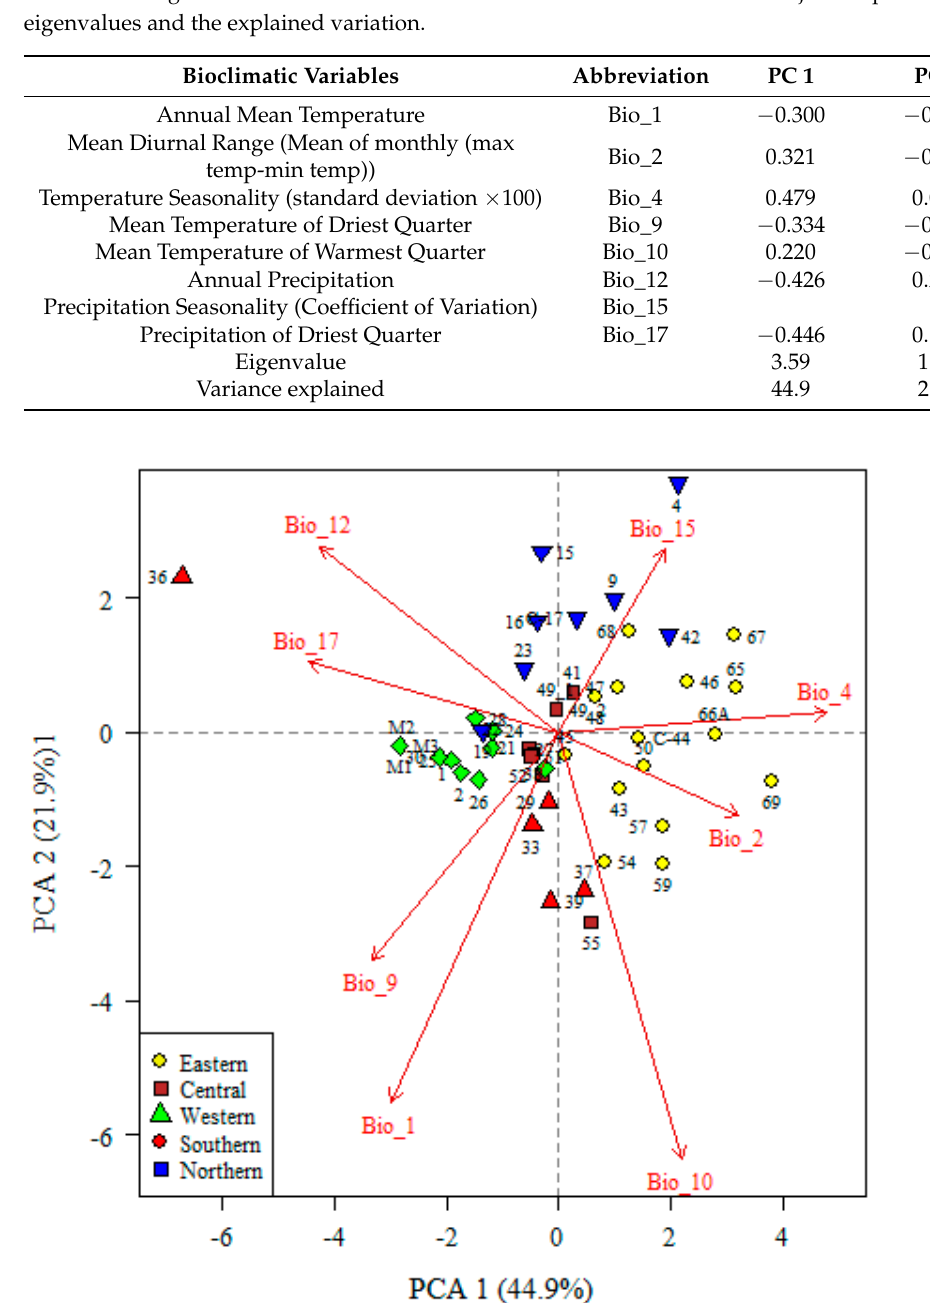
Figure 5. Climate-related variability between Scots pine provenances regarding their places of origin, based on bioclimatic